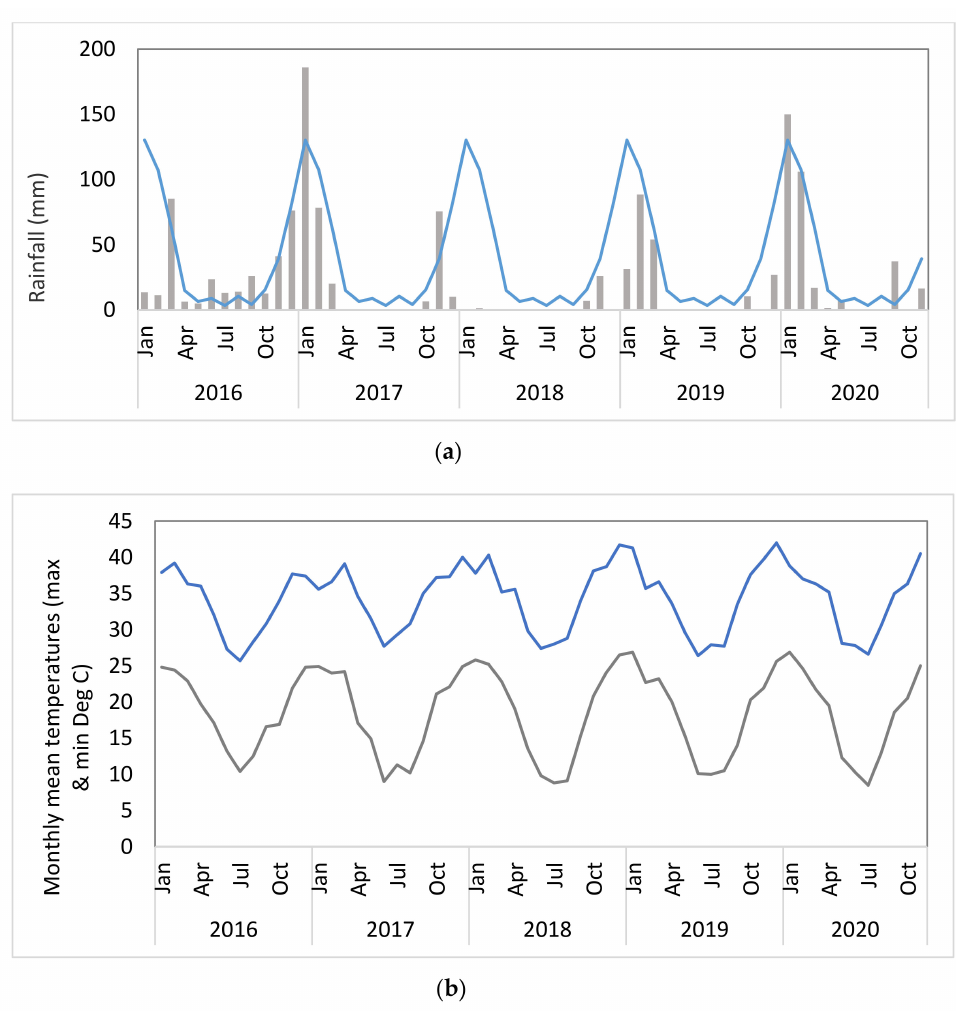
Figure 1. ( a ) Monthly rainfall totals (bars) recorded at Gallipoli outstation from January 2016 to October 2019. The line is indicative of the ten-year (2000–2019) monthly rainfall means. Data source, NAPCo. ( b ) Monthly mean maximum and mean minimum temperatures from Camooweal weather station